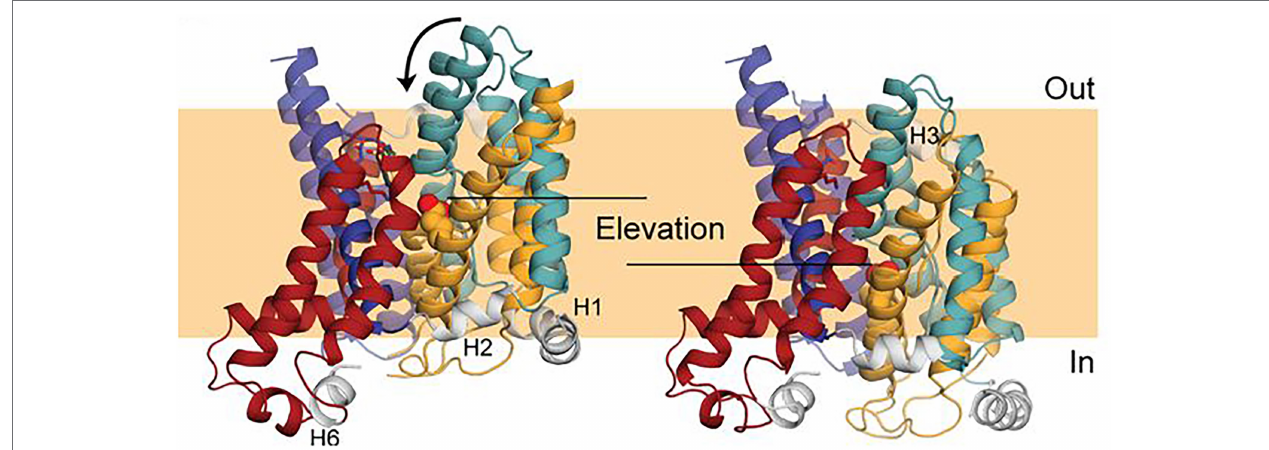
FIGURE 7 | Comparison of a repeat-swap model of the inward-facing model of Band 3 ( right ) with the 4YZF outward-facing crystal structure ( left ). The difference between the two states suggested an elevator-like conformational change with movement of the core domain relative the fixed gate domain. This figure was taken from Ficici et al. (2017) with permission of the corresponding